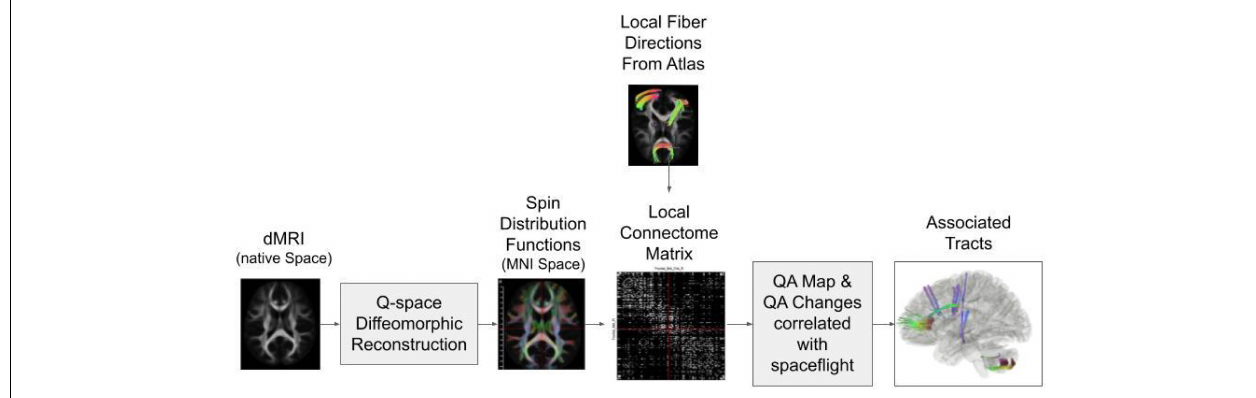
FIGURE 1 | Diagram of the connectometry analysis process. The diffusion MRI (dMRI) data from all subjects are reconstructed in MNI space through Q-space diffeomorphic reconstruction. Then the spin distribution functions are calculated from the data and compared to the predicted local fiber directions from the atlas to create a connectome matrix. A quantitative anisotropy (QA) map is calculated based on the local connectome matrix. Tractography is performed along the voxels that show QA change correlations with